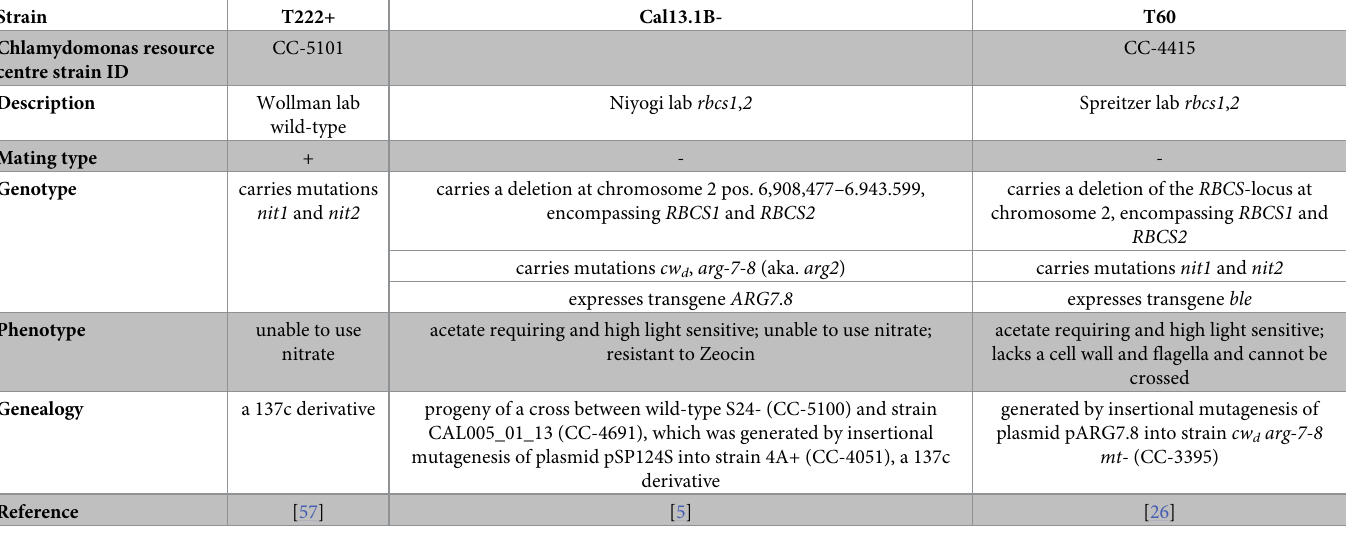
Table 1. Strains used in this